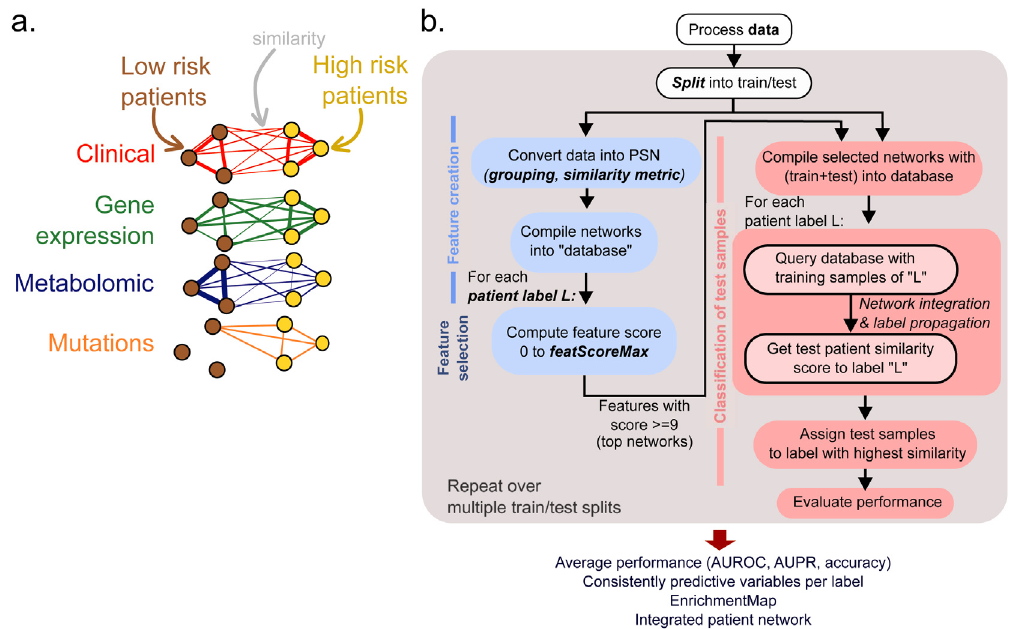
Figure 1. netDx concepts and software workflow. ( a ) Conceptual visualization of patient similarity networks. Nodes are patients and edge weights measure pairwise similarity. The example shows a two-class problem (high and low risk patients), with four features shown as patient similarity networks: similarity for clinical (red), gene expression (green), metabolomic (blue) and mutation (orange) data. ( b ) Conceptual workflow for netDx predictor. Samples are split into train and test samples, and training samples are subjected to feature selection (blue flow). Feature selection uses regularized regression to integrate networks, such that networks with non-zero regression weights have their feature score increased. This process is repeated with different subsamples of training data, for a user-provided maximum of times ( featScoreMax ). This process is repeated for each patient label. Features passing a user-specified threshold are used to classify held-out samples. Test patients are classified by highest similarity. Patient networks that combine training and test patients are then integrated; only networks from features passing selection are used for this step. Label propagation is used to compute similarity of each test patient to training samples from each label; a given patient is assigned to the class with highest similarity. Average model performance is computed by running this whole process over several train/test splits. Features with consistent high scores can be used to classify an independent validation